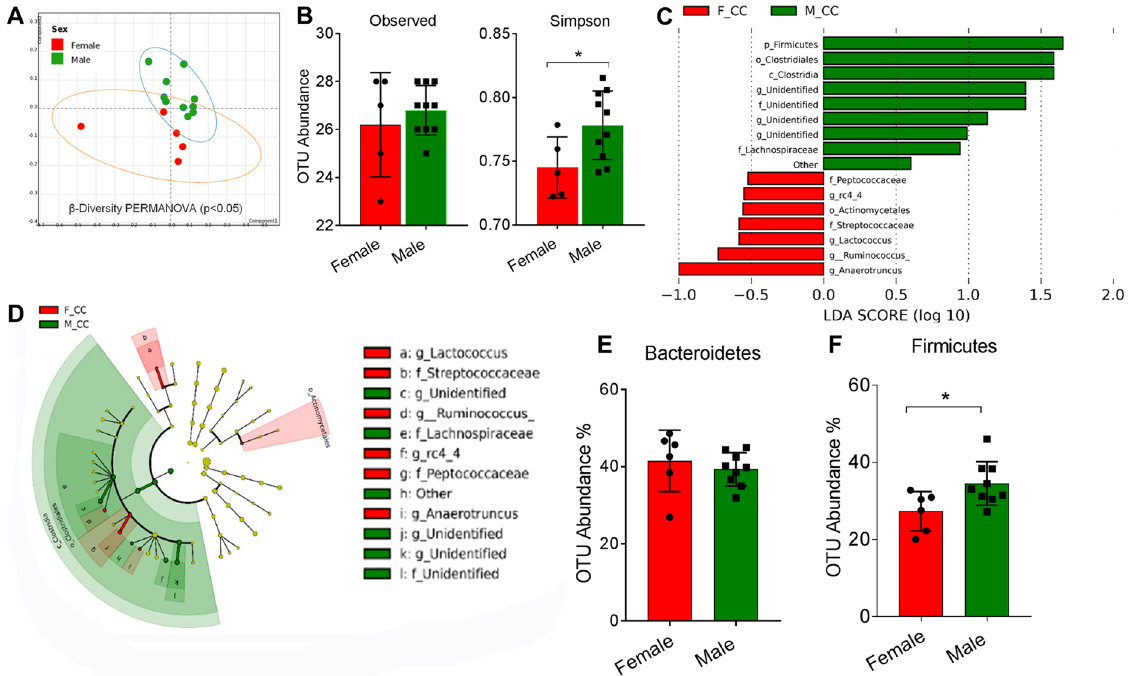
Figure 2. Sexually dimorphic nature of gut microbiome composition. ( A ) Non-metric multidimensional scaling (NMDS) ordination of the OTU dissimilarity matrix of β -diversity values. ( B ) Observed OTUs and Simpson indices representing α -diversity. ( C ) Linear discriminant analysis (LDA) coupled with effect size (LefSe) analysis showing the most differentially abundant taxonomical levels between female and male mice. ( D ) Cladogram illustrating different bacterial taxa in male and female mice. Colored nodes from the center to the periphery represent phylum (p), class (c), order (o), family (f), and genus (g) level differences detected between male (green) and female (red). ( E,F ) Overall % OTU abundance within Firmicutes and Bacteroidetes in male and female mice. Data are expressed as means ± SD. Statistical differences between male and female were determined using a Student’s t-test ( * p <